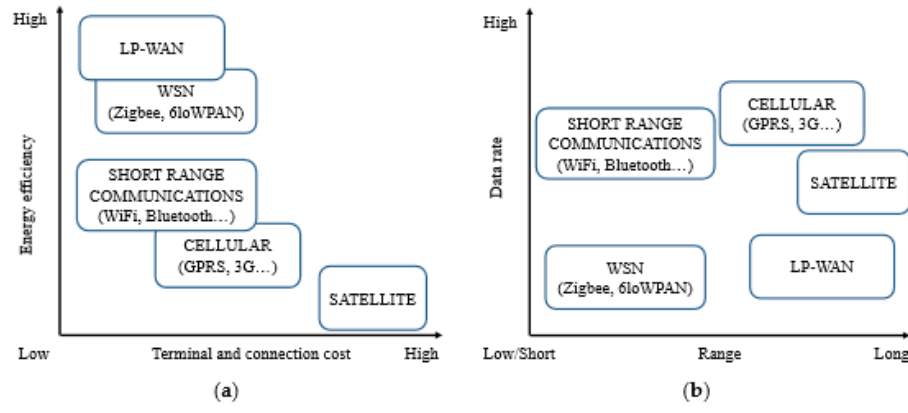
Figure 2. LPWAN is currently the state-of-the-art technology in transmitting images given global concern for low power consumption and limited bandwidth [9]. ( a ) LPWANs are the highest in energy efficiency and lowest in costs. ( b ) LPWANs are the longest in coverage range and the lowest in data